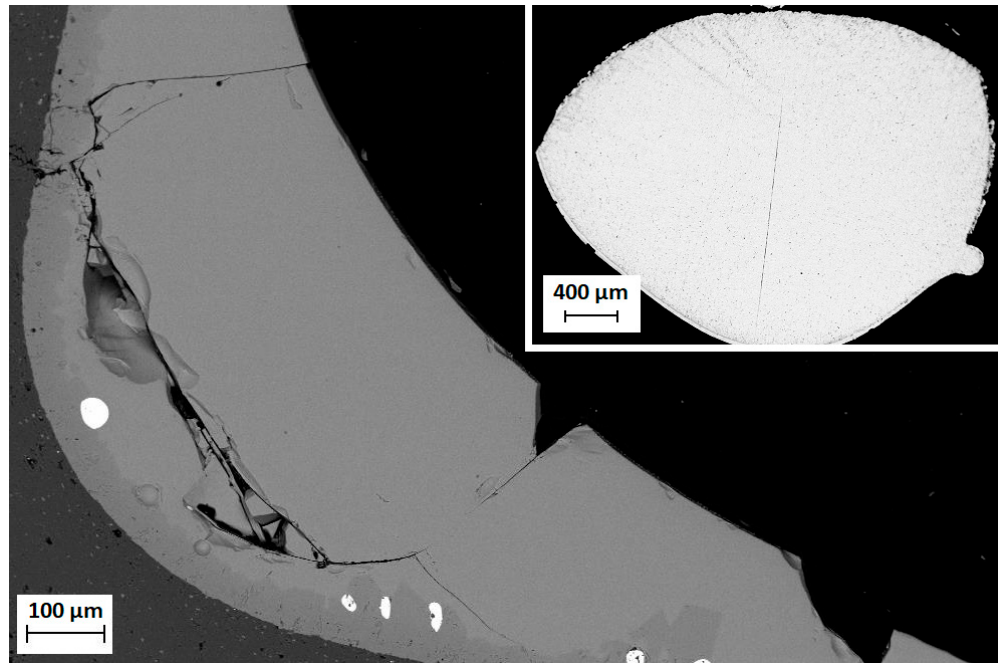
Figure 2 . SEM-BSE micrograph of the liquid slag and solid spinel layer in sample V15 (pO 2 10 − 8 atm, no K 2 O). Large copper alloy droplet (detached from the slag during quenching) is shown in the upper right corner. The dark grey in the bottom left corner is the alumina crucible, the medium grey phase is the edge spinel layer, and the lighter grey is liquid slag phase.